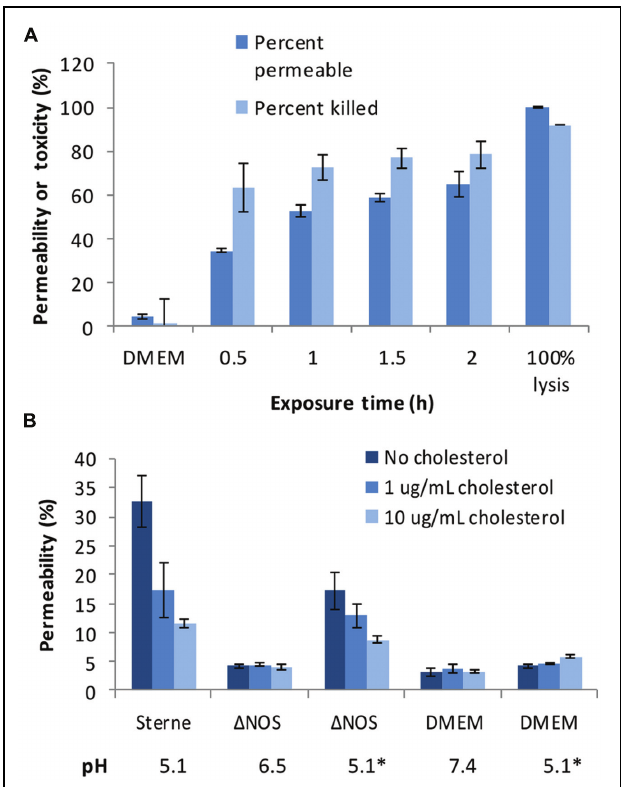
FIGURE 3 | Cell-permeabilizing effects of Sterne and (cid:2) NOS static culture sups. (A) Toxicity of the Sterne sup toward lung epithelial cells (HSAECs) correlates with increased permeability. HSAECs were exposed to the static culture sups for the indicated periods of time and the viability and permeability were tested as described in Section “Materials and Methods”. (B) Comparative effect of (cid:2) NOS and Sterne sups after a 30-min exposure of HSAECs in conditions equal to (A) . Cholesterol added to the culture medium reveals presence of the pH-dependent permeabilizing factor(s). Asterisks indicate the sups and medium titrated to the pH 5.1 of Sterne sup after cultivation. Error bars show 95% confidence intervals of triplicate measurements.